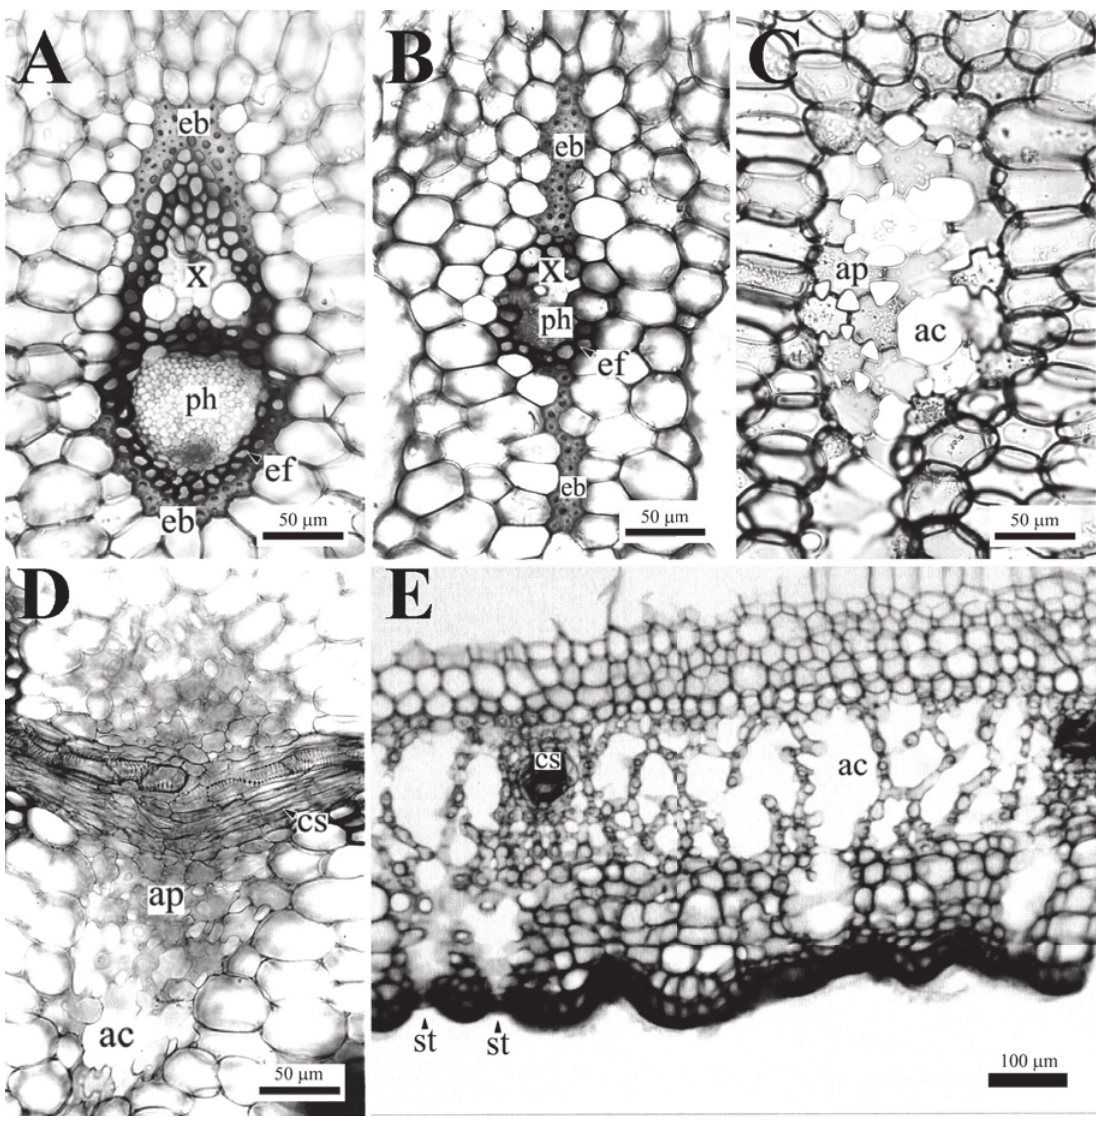
Figure 8 - Details of vascular bundles and aerial channels. (A) large vascular bundle, (B) small vascular bundle, (C) transversal view of aerial channel showing the arm-like parenchyma, (D) transversal view of aerial channel intercepted by commissural vascular bundle, (E) longitudinal view of aerial channel. ac - aerial channel, ap - arm-like parenchyma, cs - commissure, eb - extension of bundle sheath, ef - ensheathing fi bre, ph - phloem, st - stoma, x -